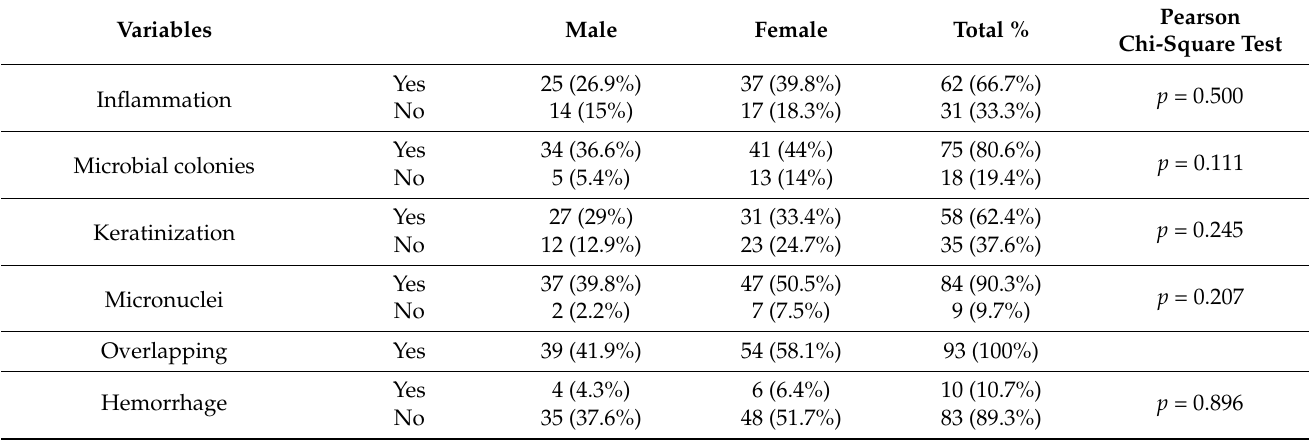
Table 2. Sex distribution concerning different cytopathological findings.